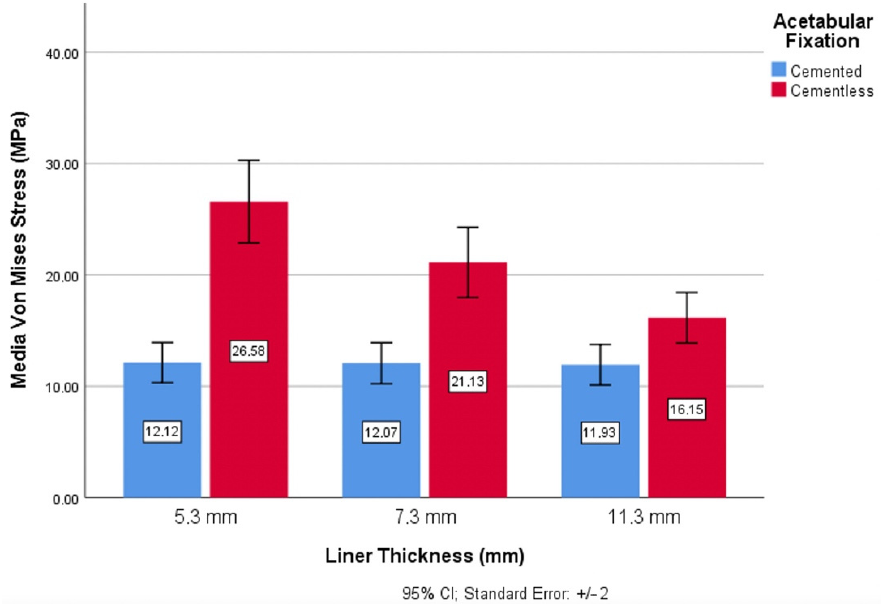
Figure 7. Wear risk through von Mises stress and liner thickness.